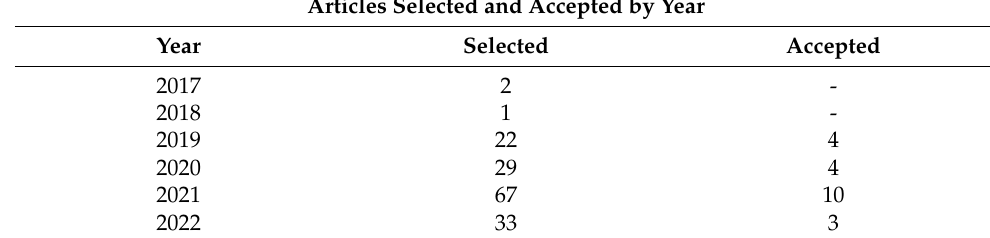
Table 11. Articles Selected and Accepted by year.